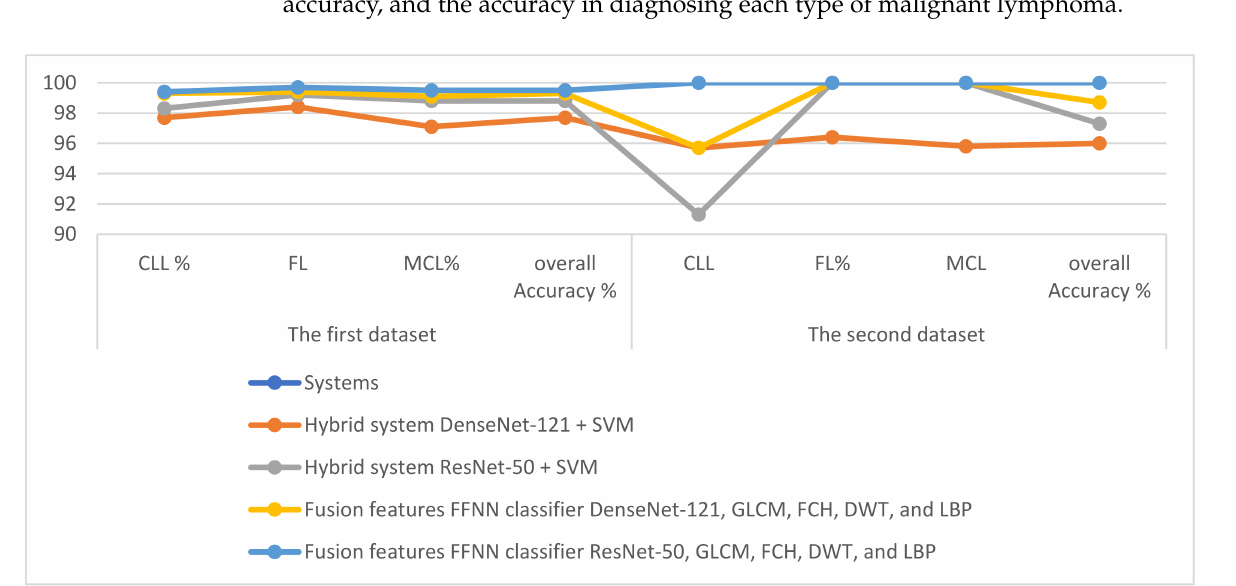
Figure 15. A presentation of the performance of the implementing systems for each type of malig- nant